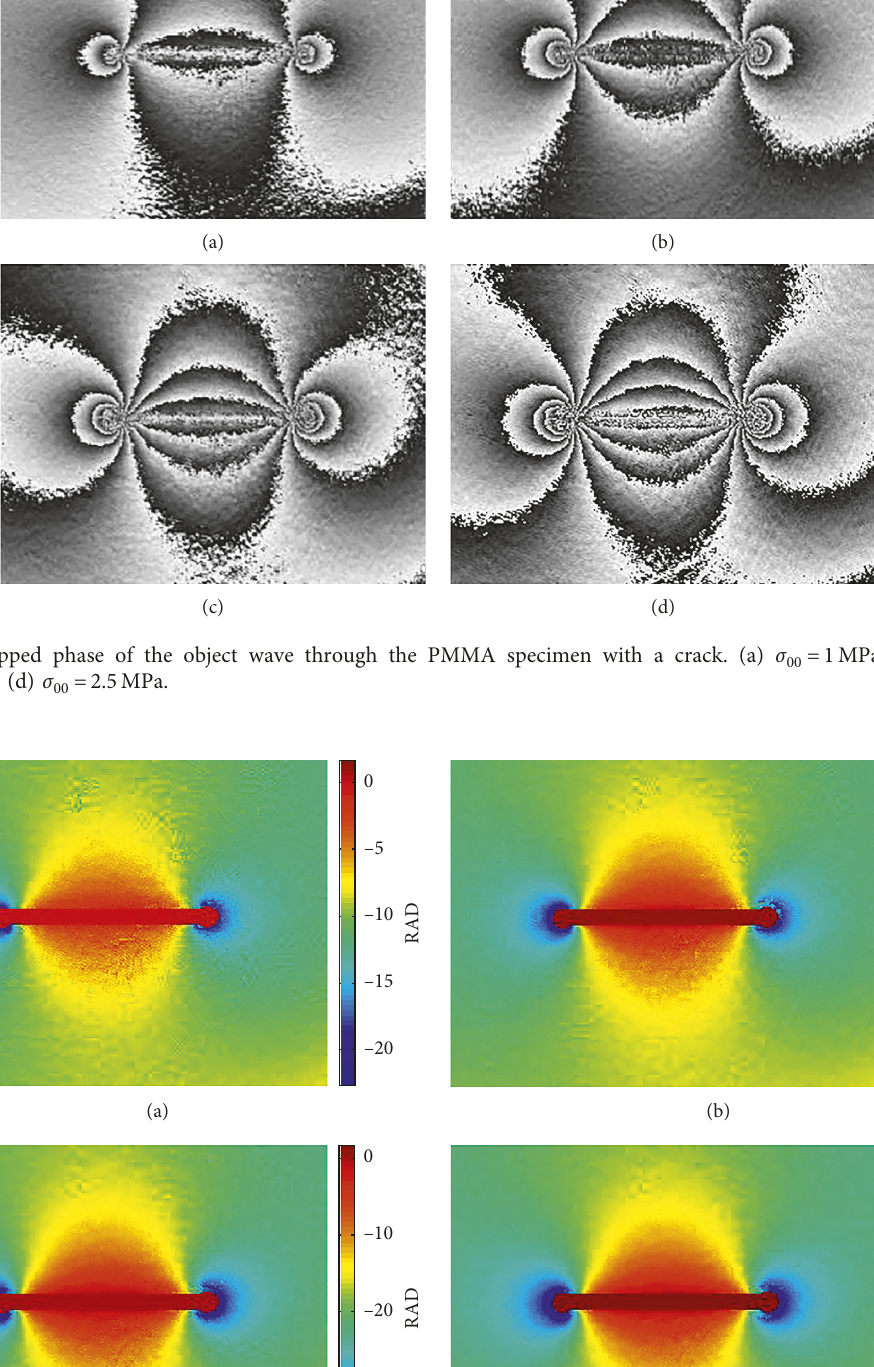
00 (cid:29) 1MPa, (b) σ 00 (cid:29) 1.5MPa,